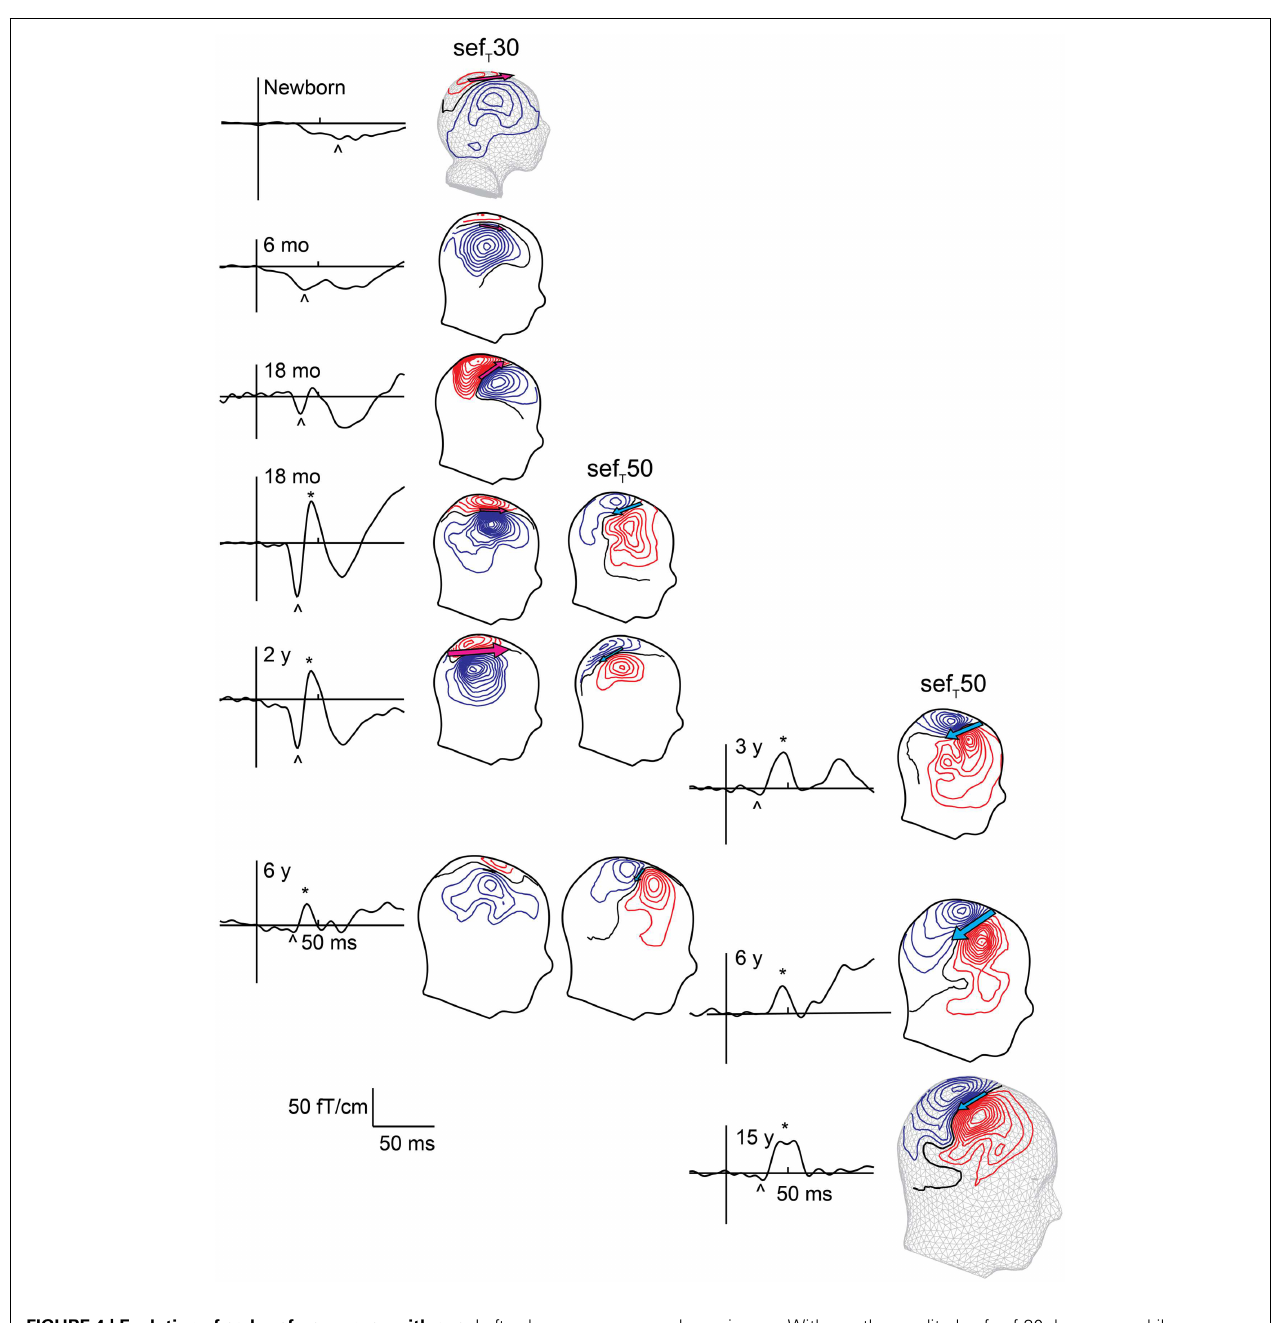
FIGURE 4 | Evolution of early sef T responses with age . Left column shows responses measured during sleep, and right column shows responses in awake subjects.The SEF waveform from one gradiometer channel shows the responses at different ages.The sef T 30 is marked with an arrowhead and sef T 50 with an asterisk. sef T 50 appears around 1–2years with inter-individual variation in timing